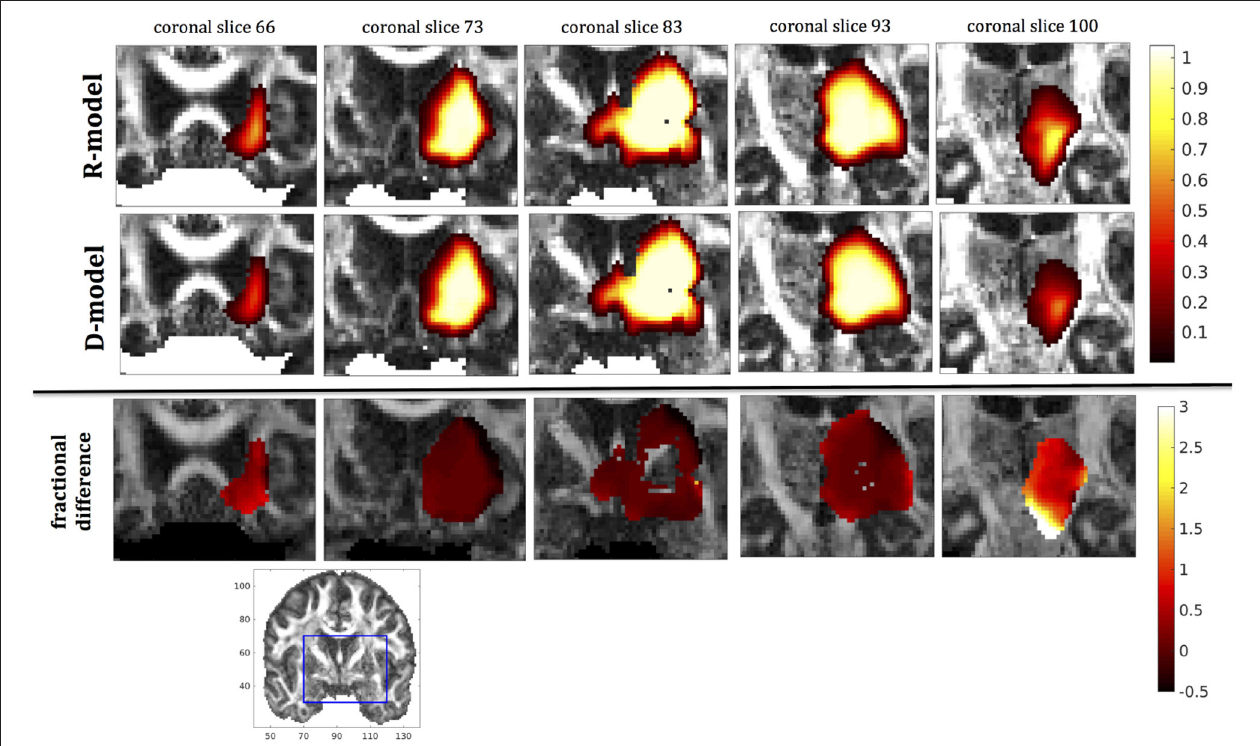
FIGURE 10 | Predicted concentrations for fast infusion in the putamen. (Top) R-model prediction for 5 coronal slices, (Middle) D-model prediction for the same ). The same scale has been used to plot the concentration distributions for the R- and the D- model. slices, (Bottom) fractional difference in concentrations ( C R − C D C D The FA image at the bottom shows in blue the part of the brain slices shown